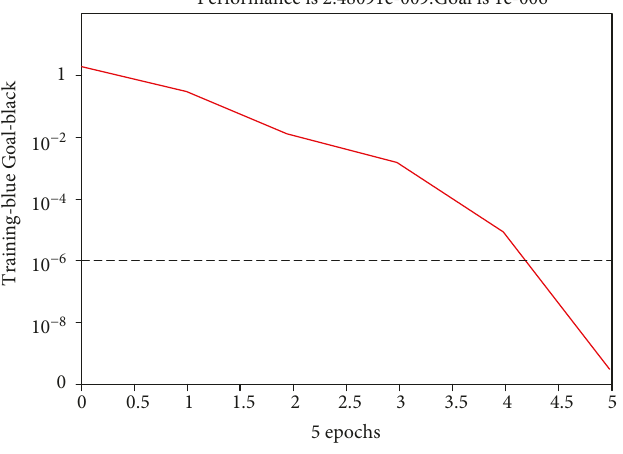
Figure 8: LM training results.